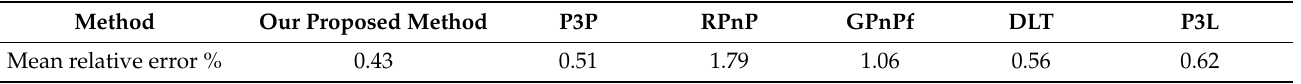
Table 2. Relative errors of position.